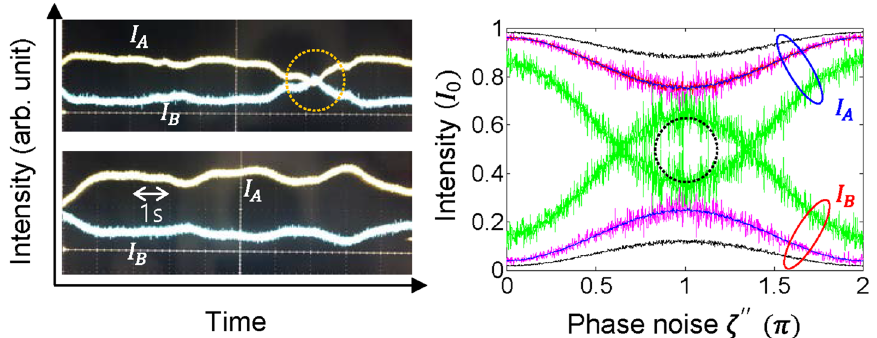
0 . (Left) Experimental results for the average of �=